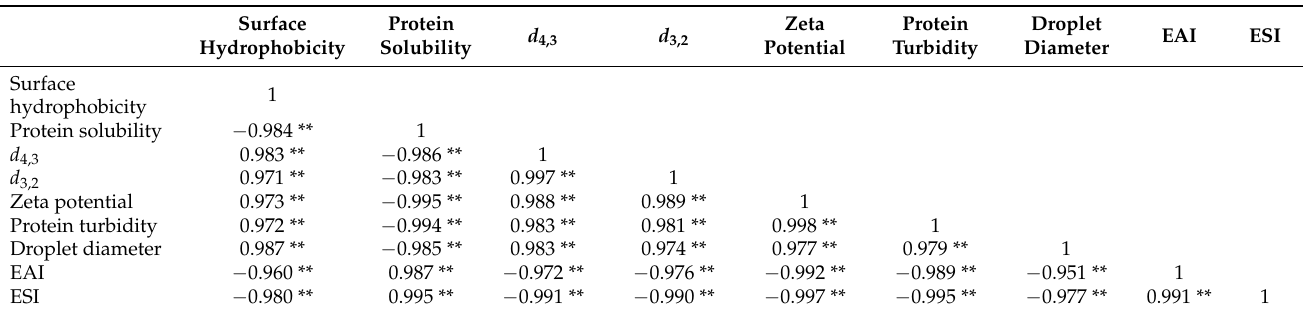
Table 2. Correlations among protein denaturation, protein aggregation, and the emulsifying property of MP from samples with different fat levels and F–T cycles.